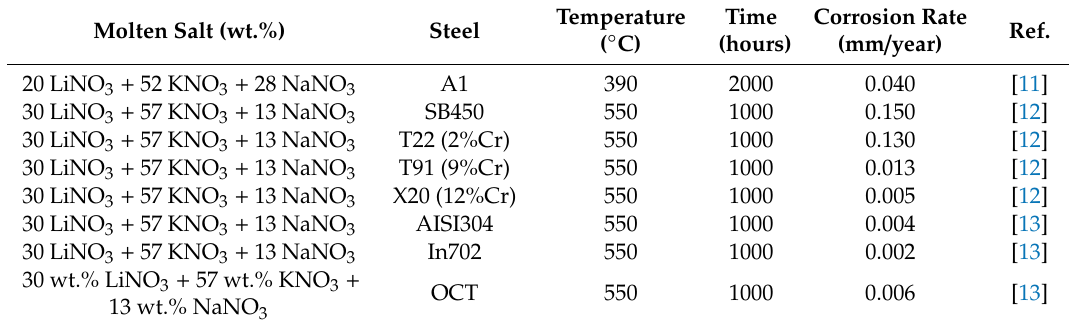
Table 2. Corrosion rates obtained in LiNO 3 ternary nitrate mixture. Molten Salt